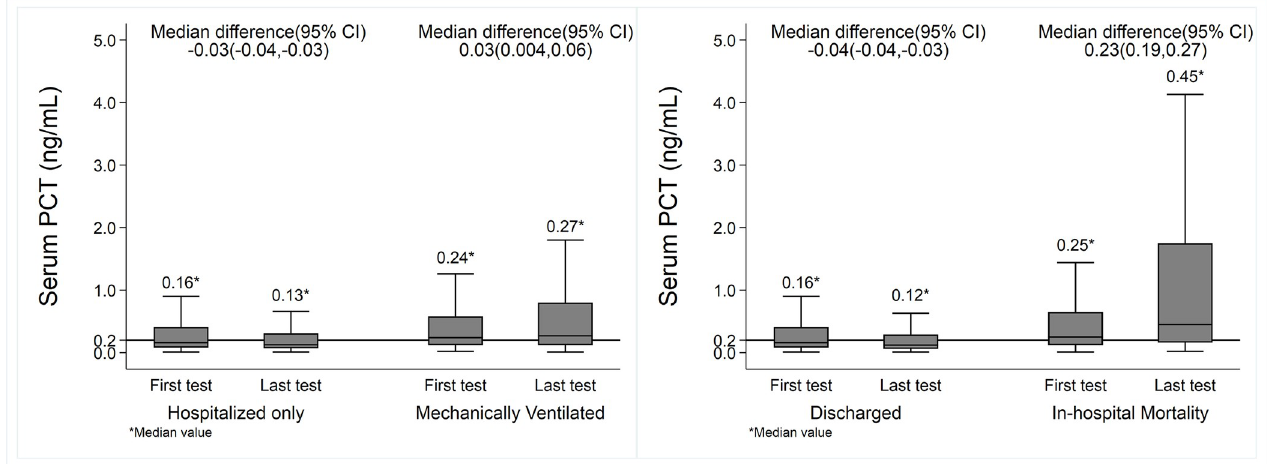
Fig 2. Boxplots showing a 5-number summary (minimum, first quartile, median, third quartile, and maximum) for first and last serum PCT levels and stratified based on final outcomes. The majority of the first test values were obtained within 2–16 days of hospitalization, while the last value was immediately prior to the reported outcomes of hospital discharge, mechanical ventilation, or in-hospital death. The boxes extend from the 25th to the 75th percentile, with whiskers extending to the minimum and maximum points. Outliers are not shown in the box